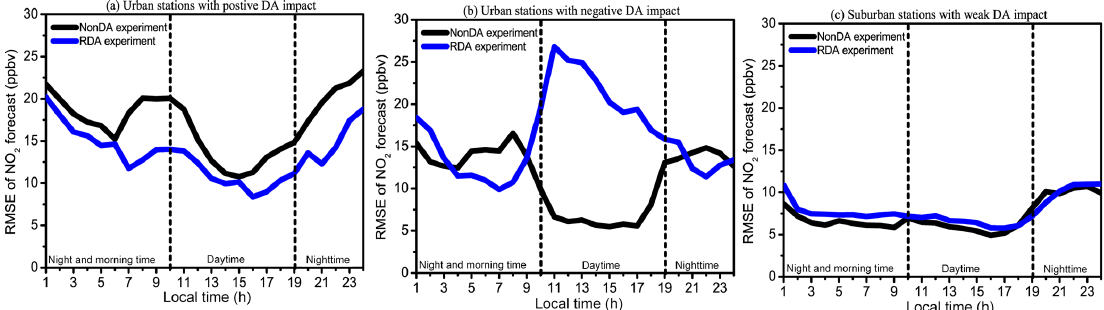
Figure 3. Daily variation of the 1h NO 2 forecast RMSE (ppbv) in the RDA experiments (blue line) and the reference (NonDA) experiment with a free run of the model (black line) over (a) urban stations (CZ, PEK, QHD, SJZ, and TS) with positive DA impacts; (b) urban sites (BY, CP, IAP, TJ, and YF) with negative DA impacts; (c) suburban stations (LF, XH, YLD, YJ, and YuF) with weak DA